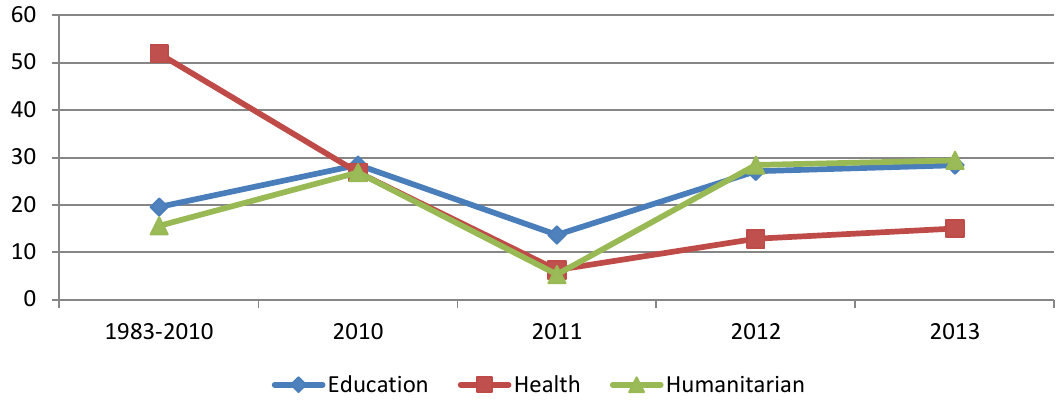
Figure 2. Sector wise expenditures on CSR (in percentage) by